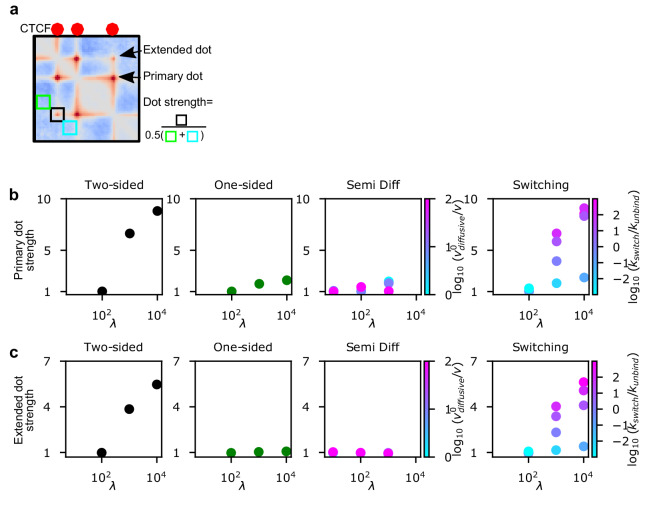
The primary and extended dot strength for two-sided, one-sided, semi-diffusive and switching LEFs.(a) The definition of dot strength and primary and extended dots. The divergent color scale of the contact map emphasizes that dot strengths are computed on contact maps after computing observed-over-expected (Materials and methods). (b) Strength of primary dots for increasing processivity at a constant LEF separation, d = 200 kb. (c) Strength of extended dots for increasing processivity at a constant LEF separation, d = 200 kb.